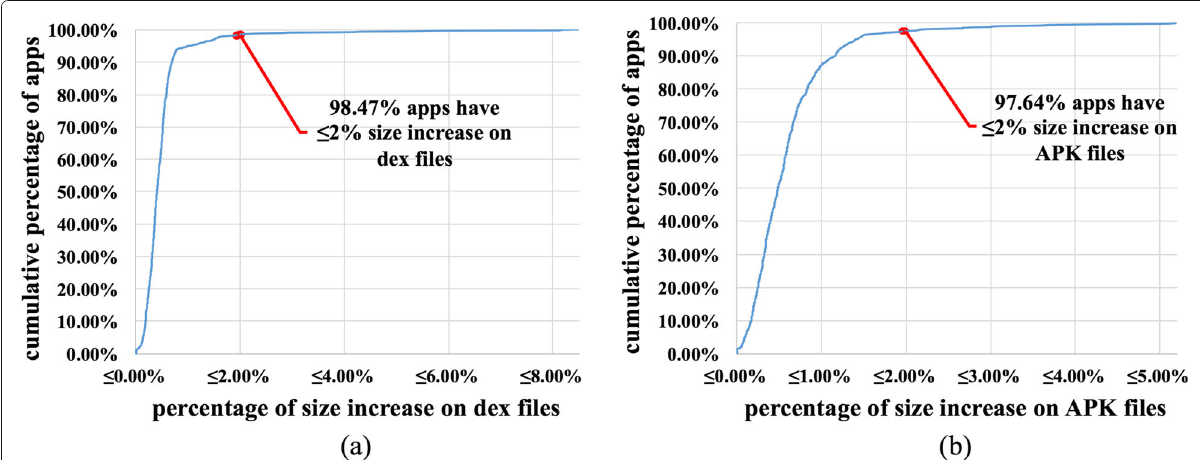
Fig. 5 a , b CDF for the size increase of dex and APK files. The cumulative distribution function (CDF) for the size increase of dex files and APK files incurred by Sensor Guardian’s instrumentation